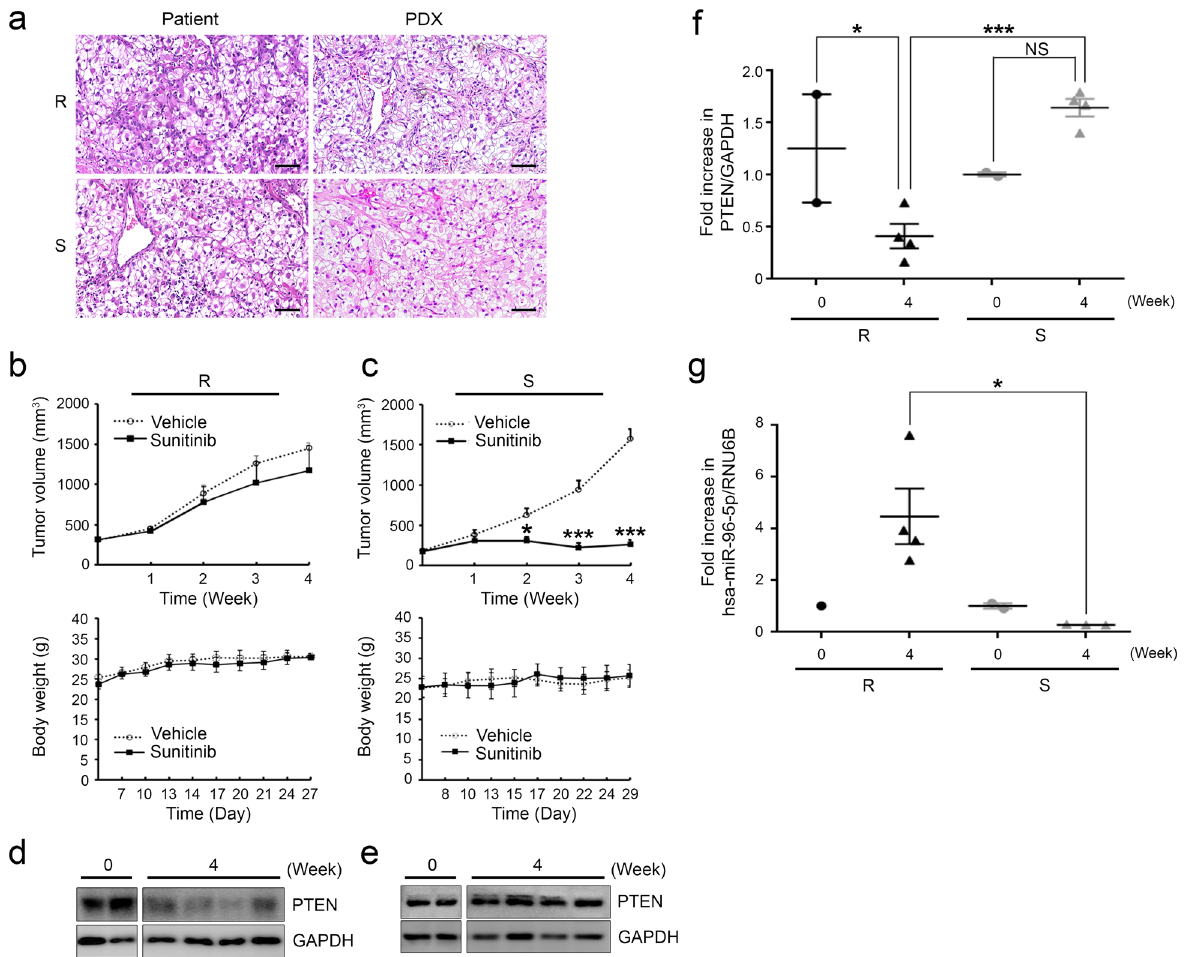
Figure 4. Modulation of sunitinib sensitivity by the miR-96-5p/PTEN axis in CCRCC patient-derived xenografts (PDXs). ( a ) H&E staining images of tumors from original sunitinib-resistant and sunitinib-sensitive patients and their corresponding PDXs (scale bar = 50 μm). ( b , c ) PDX models were divided into two treatment groups: vehicle and 40 mg/kg sunitinib. Body weight and tumor volumes were assessed for changes over time (Vehicle n = 4; sunitinib n = 4, mean ± s.e.m., * P < 0.05, *** P < 0.001, one-way ANOVA). ( d , e ) Comparison of the expression of PTEN between sunitinib-resistant (d) and sunitinib-sensitive PDX (e) at 0 and 28 days; GAPDH, internal control. ( f, g ) PTEN (f) and miR-96-5p (g) expression from tissue of sunitinib-resistant PDX, compared with the sunitinib-sensitive counterparts (mean ± s.e.m., * P < 0.05, *** P < 0.001, one-way ANOVA, n = (Fig. 5b, black bars). Notably, this repression was sequence-specific; a mutant reporter construct with mutations of two nucleic acids in the miR-96-5p binding site failed to show any suppression (Fig. 5b, white bars). To confirm the induction of resistance to sunitinib via repressing PTEN expression by miR-96-5p in CCRCC cell lines, we first analyzed the levels of PTEN and miR-96-5p in A498, TK10, and ACHN kidney cancer cell lines. The results of Western blot and qRT-PCR showed that the level of PTEN expression was higher in A498 cells than in TK10 and ACHN cells (Fig. 6a, b). In contrast, the level of miR-96-5p was inversely correlated with PTEN expression in A498, TK10, and ACHN cells (Fig. 6c). These cell lines were exposed to 20 μM sunitinib for 24 h, after which we measured the cell viability and death. Interestingly, A498 cells, which showed high PTEN and low miR-96-5p levels, were highly sensitive to sunitinib compared with TK10 and ACHN (Fig. 6d, e). Next, we manipulated the expression of miR-96-5p by infecting RCC cell lines with lentiviruses expressing either miR- 96-5p mimic or miR-96-5p inhibitor and then assessed the PTEN levels and sunitinib sensitivity by evaluating various cellular phenotypes. Infection of miR-96-5p-expressing lentivirus decreased PTEN proteins significantly in A498 cells (Fig. 7a) and made the cells resistant to sunitinib by increasing cell viability and decreasing cell death (Fig. 7b, c). In addition, the overexpression of miR-96-5p significantly increased the invasion ability of A498 cells in the presence of sunitinib (Fig. 7d). In contrast, infection of ACHN cells with miR-96–5-p inhibitor increased PTEN expression (Fig. 7e) and enhanced sensitivity to sunitinib by decreasing cell viability and increasing cell death (Fig. 7f, g). In addition, after reestablishment of the levels of PTEN in miR-96-5p-expressing A498 cells by infection with PTEN-expressing lentivirus (Fig. 7h), the sensitivity to sunitinib was restored (Fig. 7i). Taking these findings together, the downregulation of PTEN directly by miR-96-5p in part contributed to the resistance to sunitinib in CCRCC cell lines.